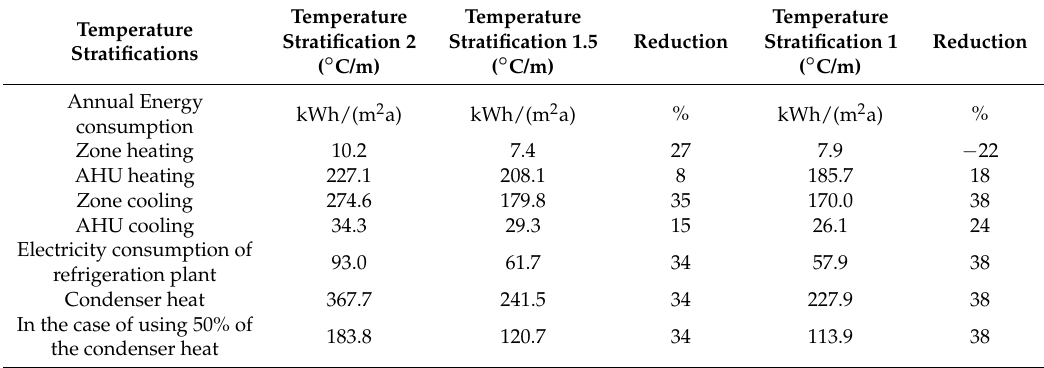
Table 4. Simulation results of the yearly energy consumption of ice rinks with different temperature gradients. Temperature